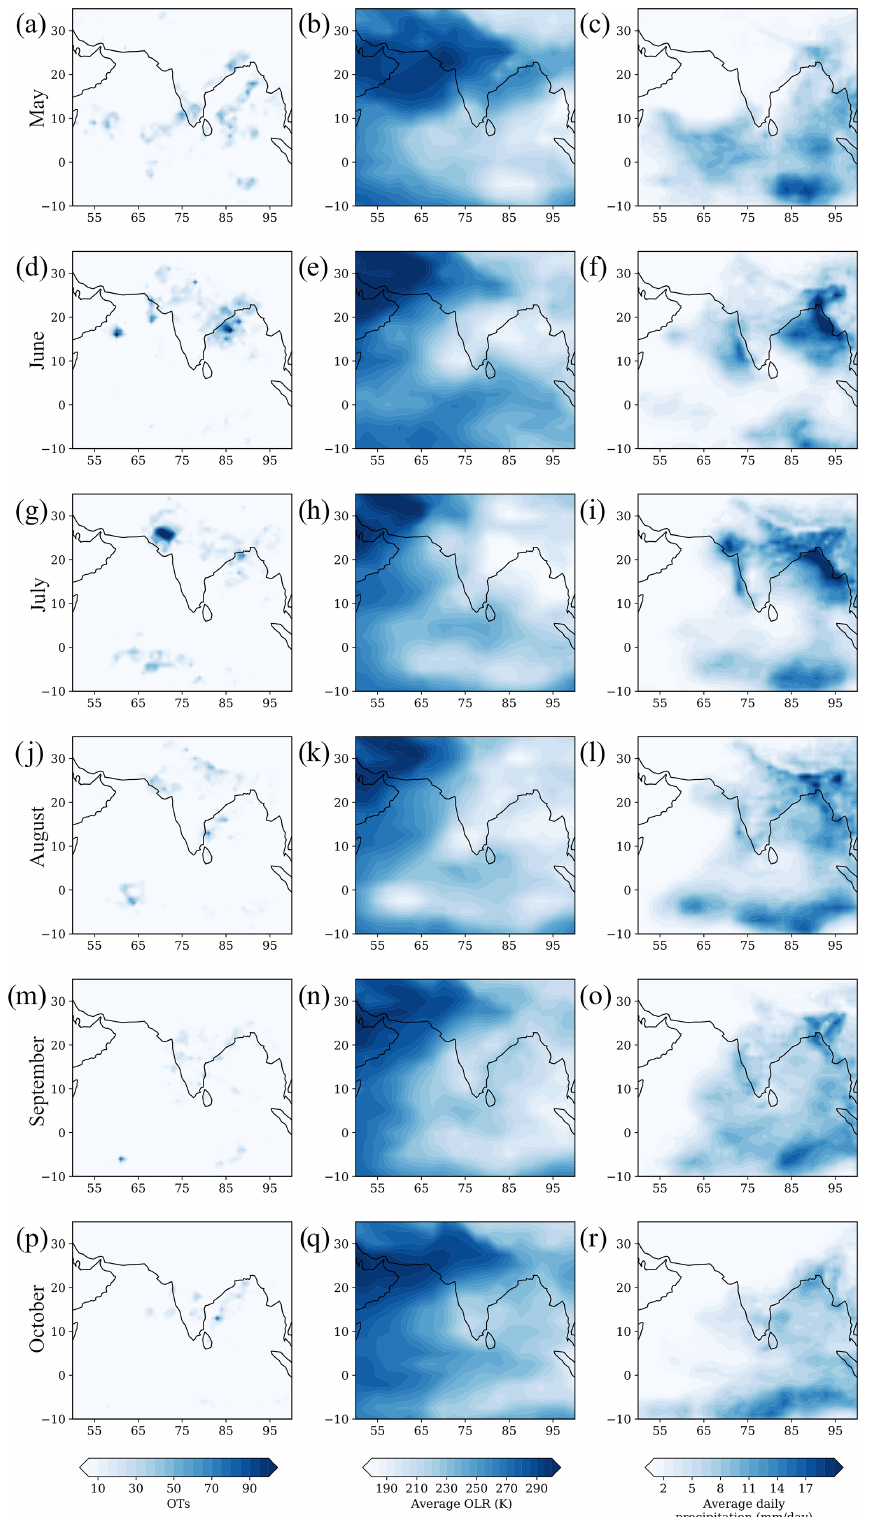
Figure 6. The geographic distribution of monthly convection as shown by OTs (left column), daily average OLR (middle column), and daily average precipitation (right